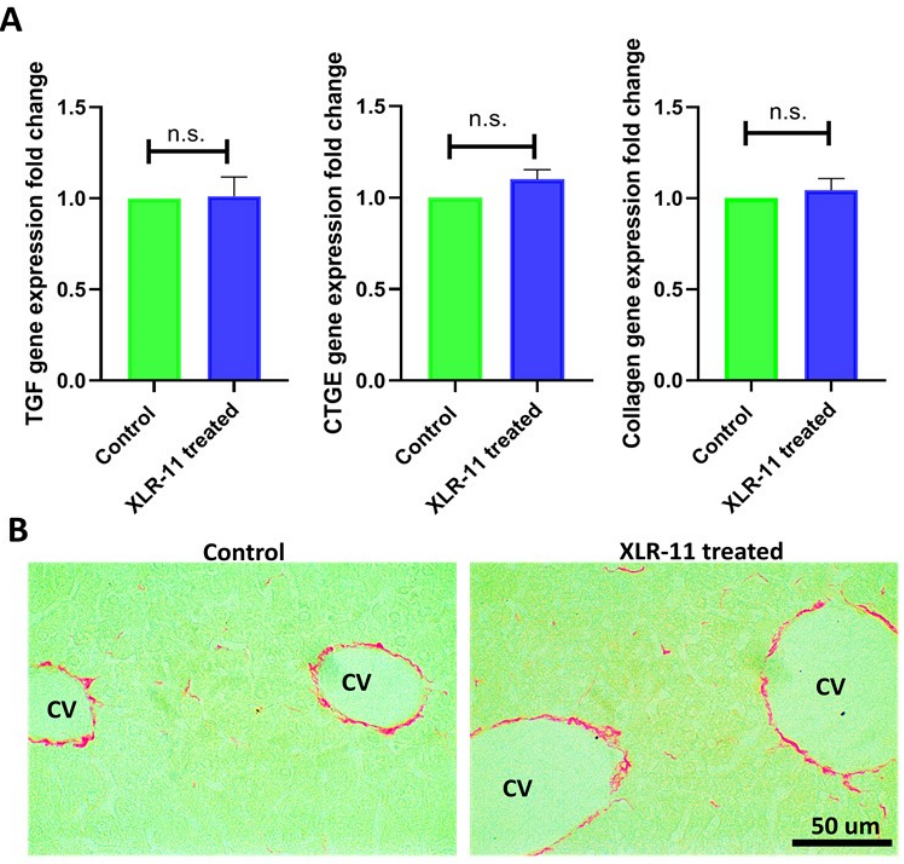
Figure 6. ( A ) Gene expression of fibrosis markers TGF- β , CTGF, Collagen 1 in liver of XLR-11 treated mice compared to control mice. ( B ) Picro-Sirius Red Stain of the liver from control mice and XLR-11 treated mice. Normal degree of fine liner red collagen fibers in the wall central veins in XLR-11 treated mice indicating no hepatic fibrosis; cv: central vein, n.s. indicate no significance.